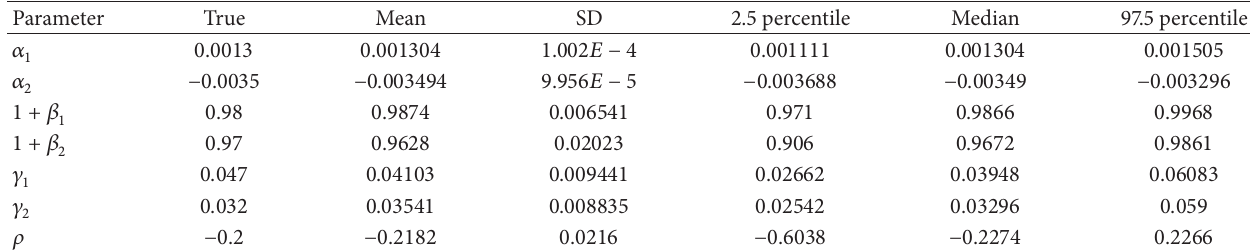
Table 1: Estimation results for simulated